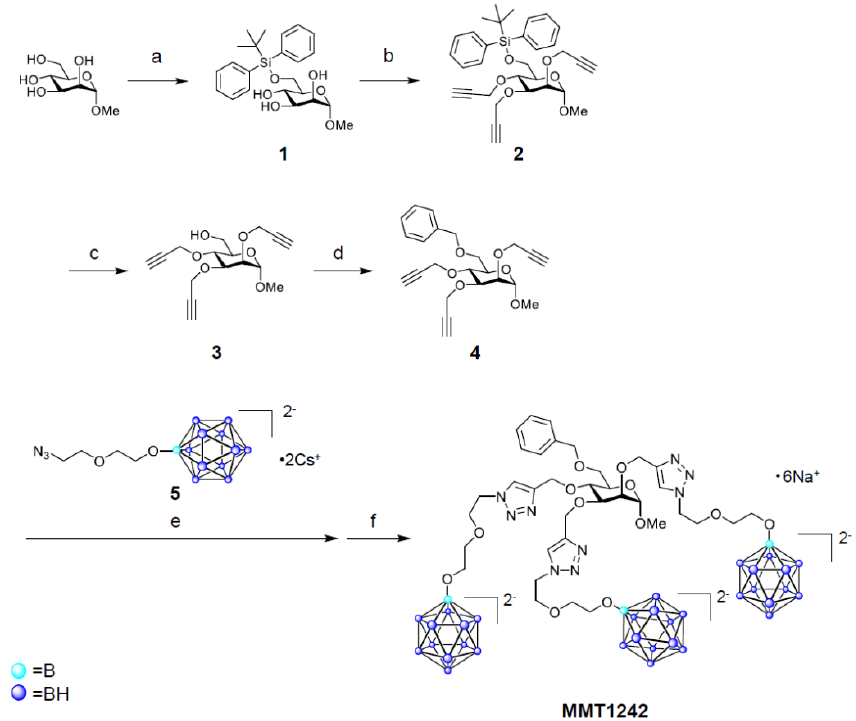
Figure 1. Synthesis of MMT1242. Reaction conditions and yields: ( a ) tert -butylchlorodiphenylsilane, imidazole, N , N -dimethylformamide, 5 °C to rt (quant.); ( b ) sodium hydride, N,N -dimethylformamide, 5 °C to rt, then propargyl bromide, cat. tetrabutylammonium iodide, 5 °C to rt (68%); ( c ) tetrabutylammonium fluoride, tetrahydrofuran, 5 °C to rt (91%); ( d ) sodium hydride, N,N -dimethylformamide, 5 °C to rt, then benzyl bromide, rt (53%); ( e ) 5 , copper (II) sulfate pentahydrate, sodium L -ascorbate, tert -butanol/H 2 O (1/2, v / v ), 70 °C; ( f ) Amberlite ® IR120B Na, H 2 O, (25%, 2 steps).